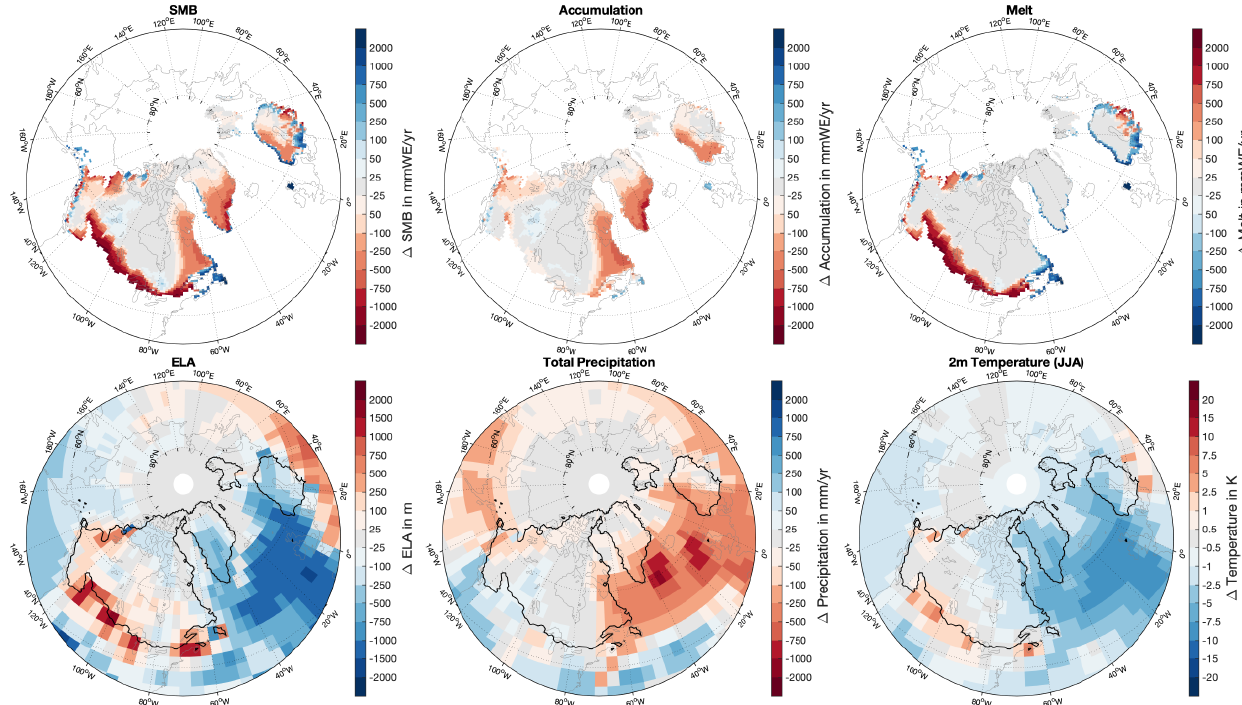
Figure 6. Similar to Fig. 5 but for differences between 14.6 and 15ka.